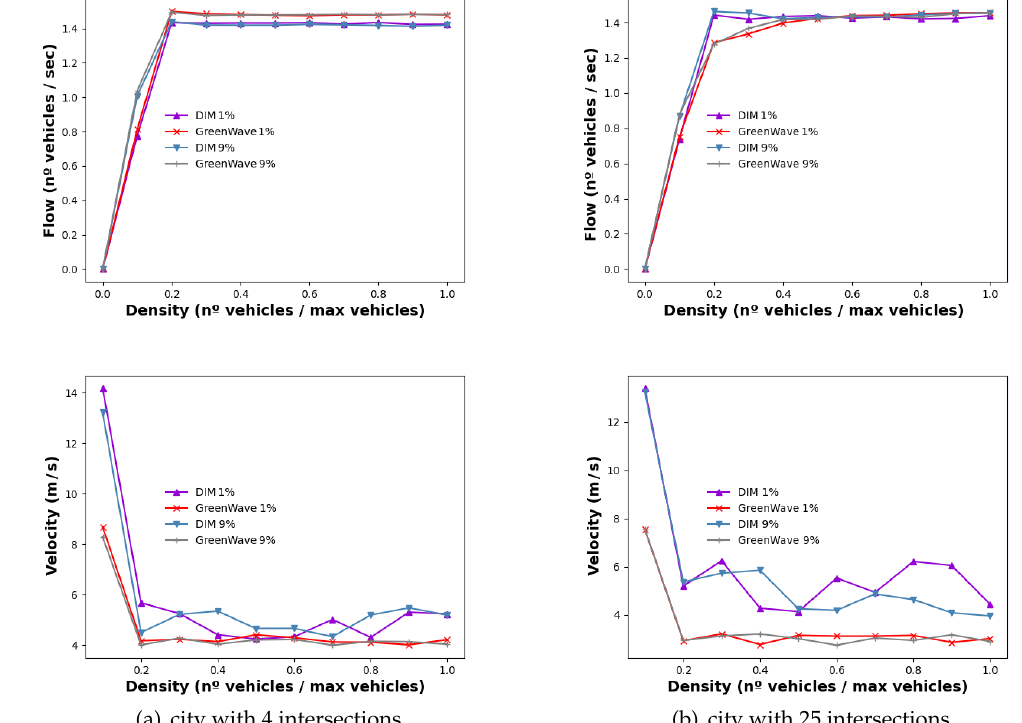
Figure 3. Model comparison with emergency vehicles at 1% in two different Figure 3. Models comparison with emergency vehicles at 1% on two different cities